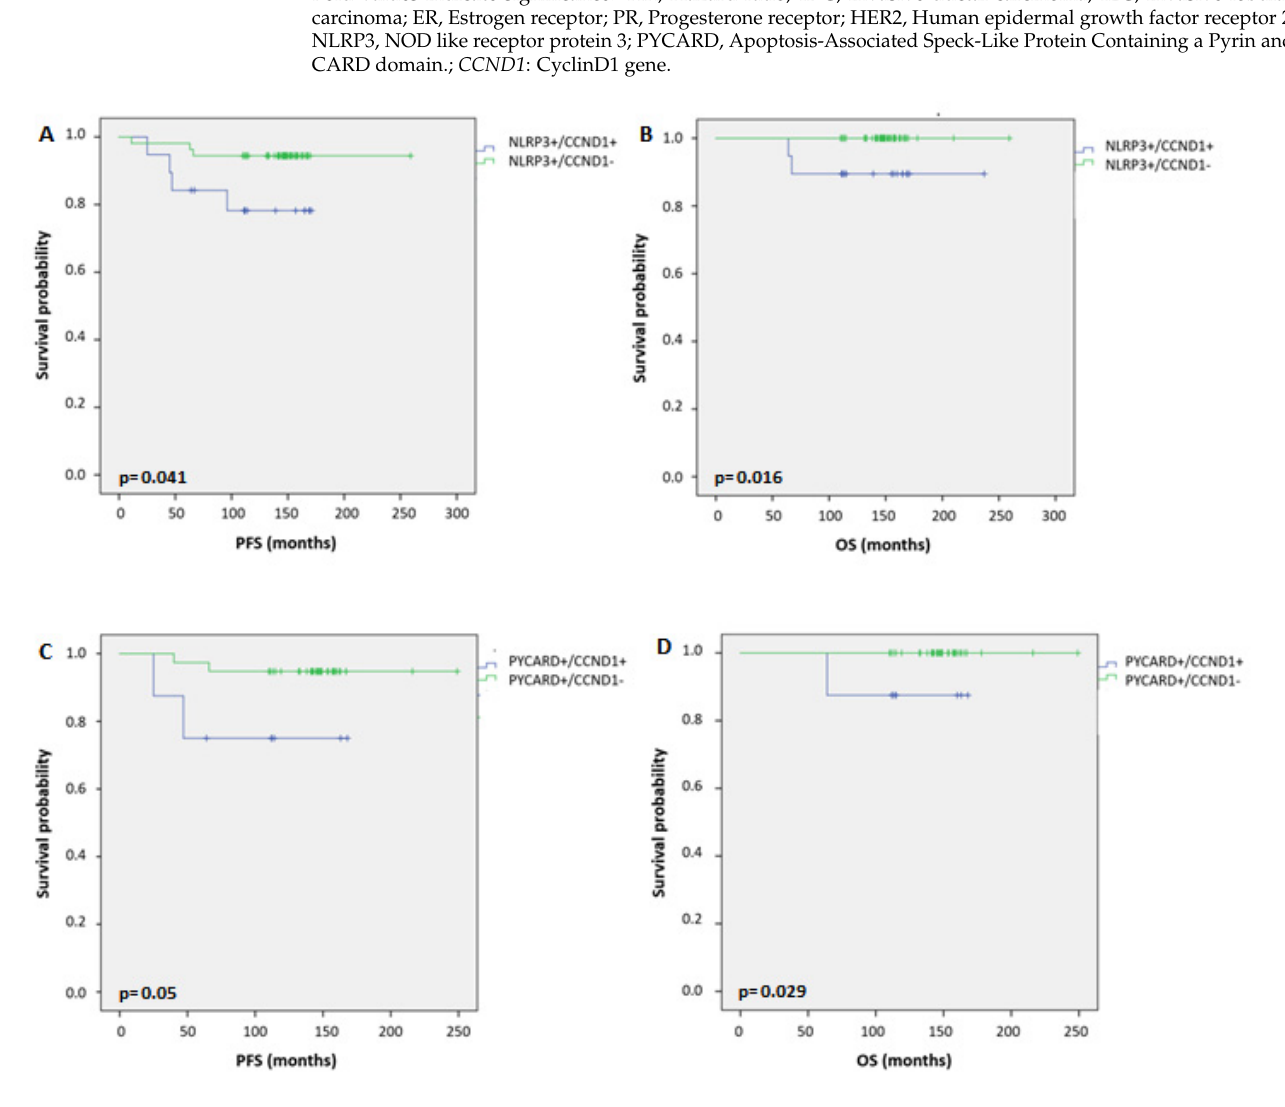
Figure 5. Kaplan–Maier curve analysis. ( A ) Kaplan–Maier curve for progression-free survival (PFS) according to NLRP3+/ CCND1+ versus NLRP3+/ CCND1 − patients ( p = 0.041). ( B ) Kaplan–Maier curve for overall survival (OS) according to NLRP3+/ CCND1+ versus NLRP3+/ CCND1 − patients ( p = 0.016). ( C ) Kaplan–Maier curve for PFS according to PYCARD+/ CCND1+ versus PYCARD+/ CCND1 − patients ( p = 0.05). ( D ) Kaplan–Maier curve for OS according to PYCARD+/ CCND1+ versus PYCARD+/ CCND1 − patients ( p =